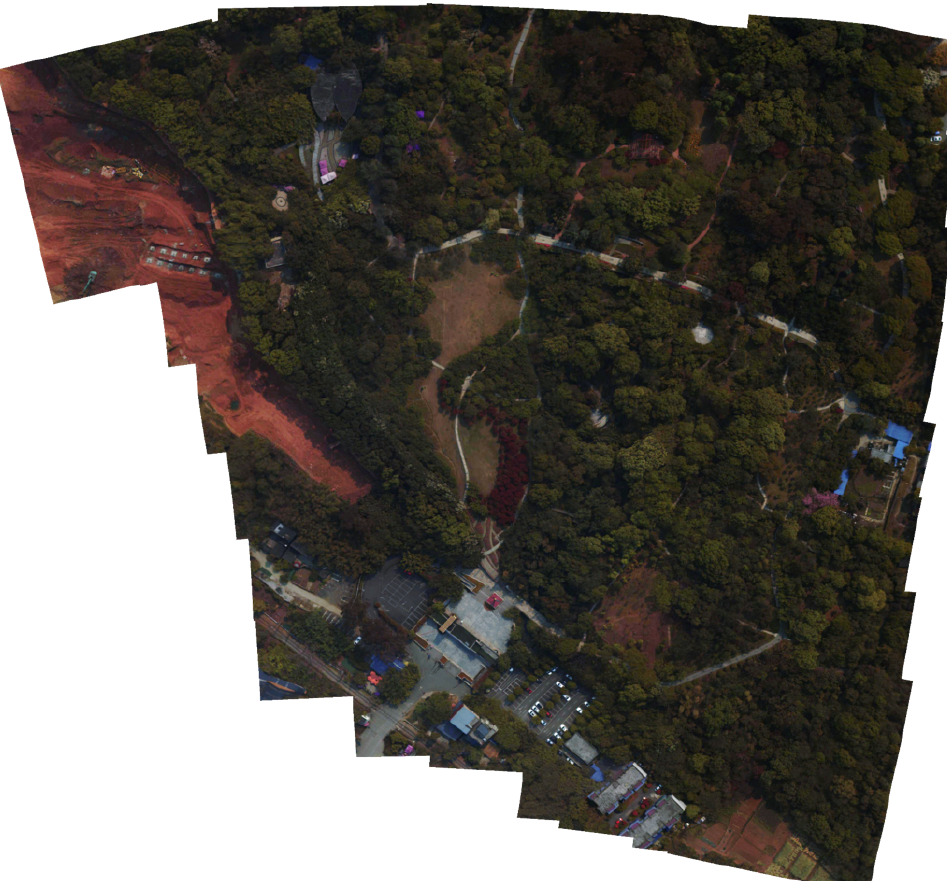
Figure 11. The final result of stitching 54 hyperspectral images in the HSI dataset using our method.